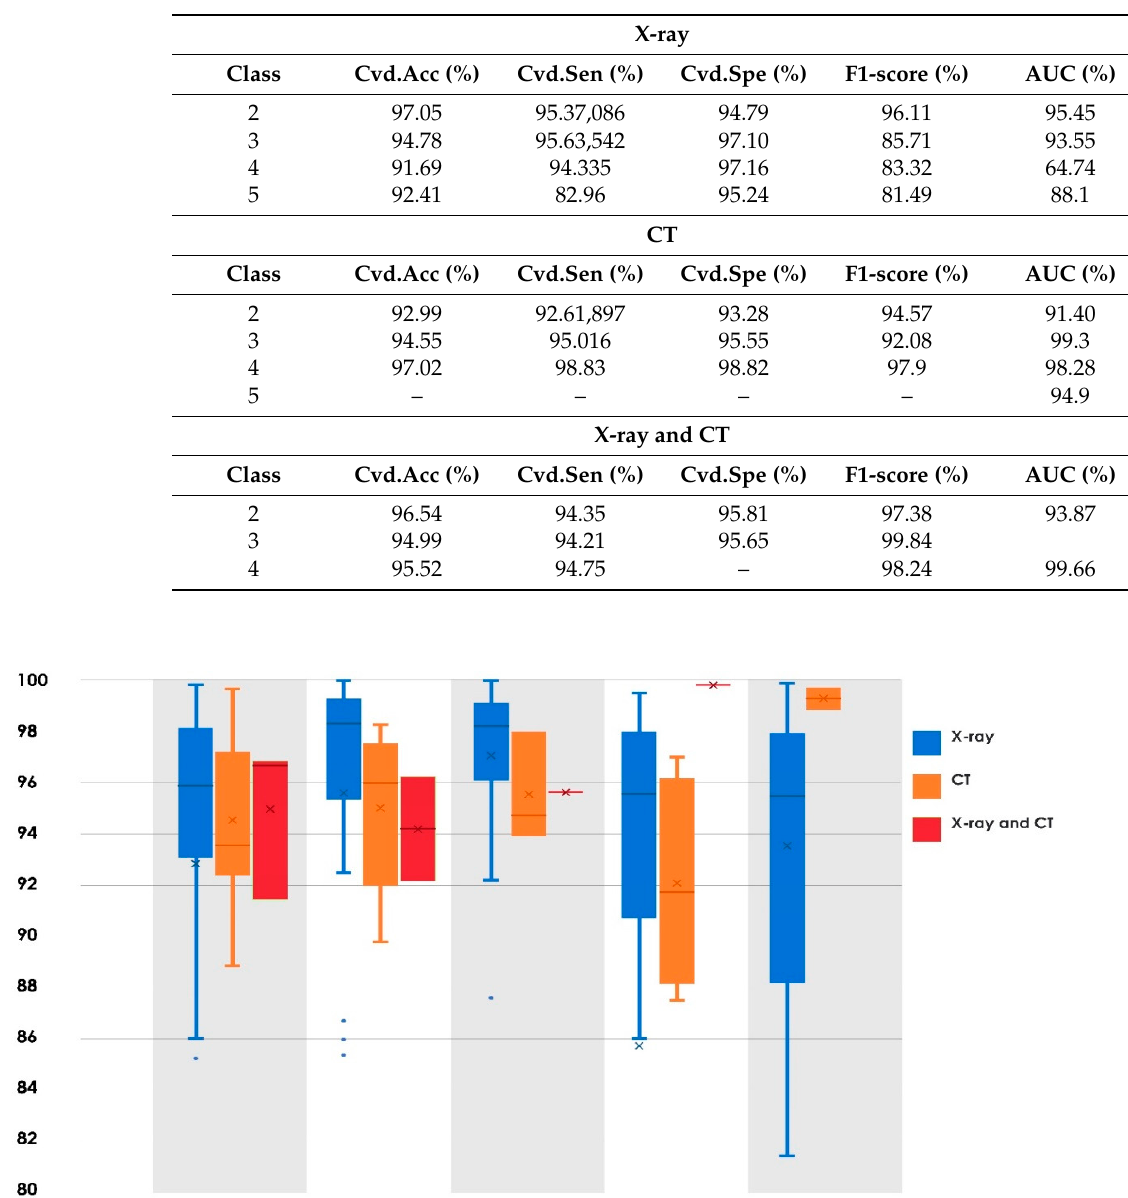
Table 6. Average (Avg.) performance of COVID-19 detection systems.